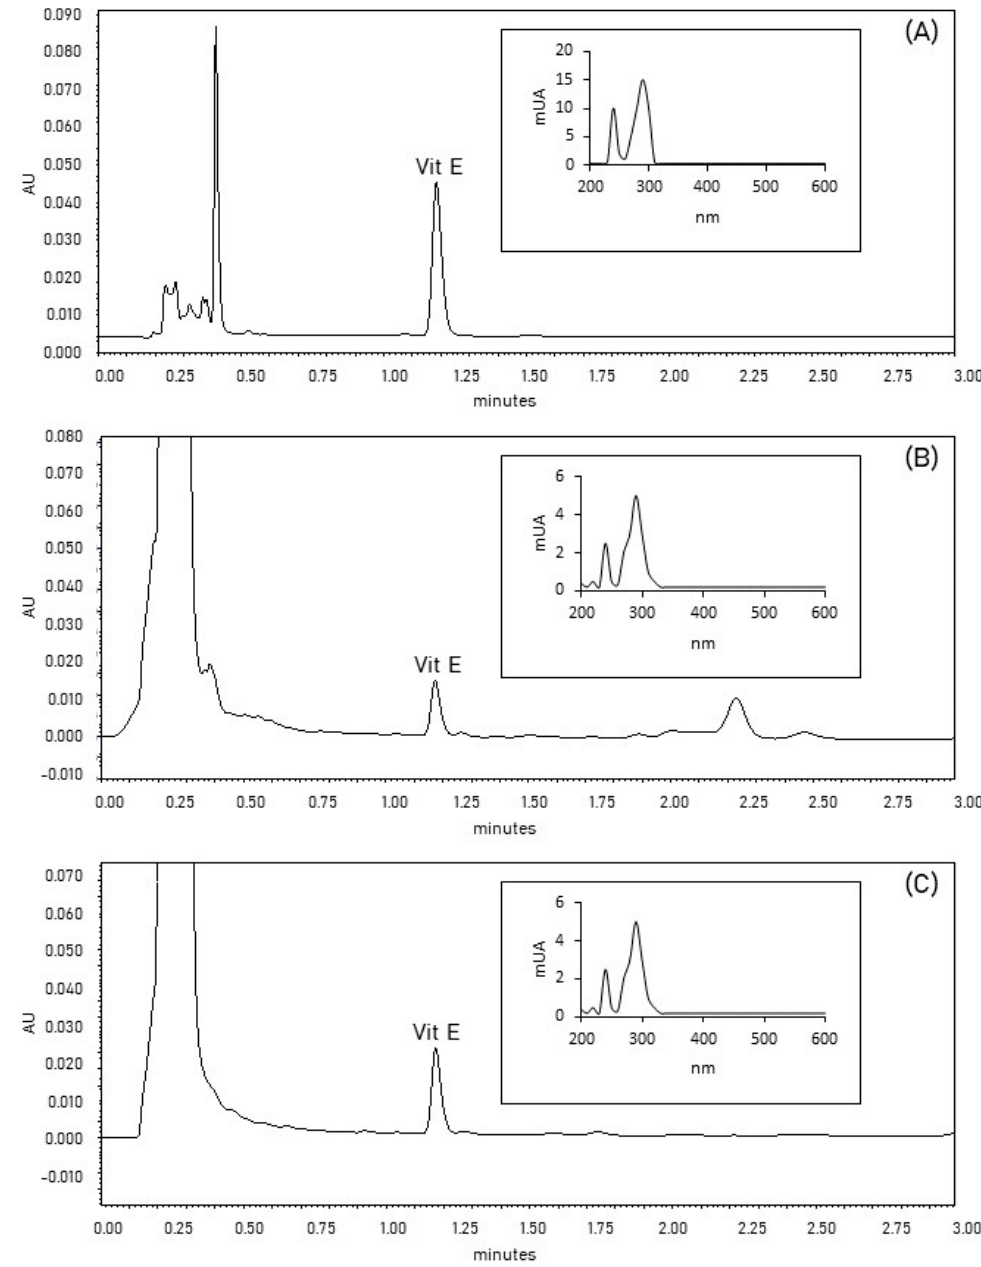
Figure A3. Chromatograms of Vitamin E (vit E) at 290 nm. ( A ) Standard. ( B ) Extracted from unripe Habanero pepper grown in black soil and harvested at 320 PTD. ( C ) Extracted from ripe Habanero pepper grown in black soil and harvested at 320 PTD. Extraction method: it was carried out with the same extraction methodology of the carotenoids.